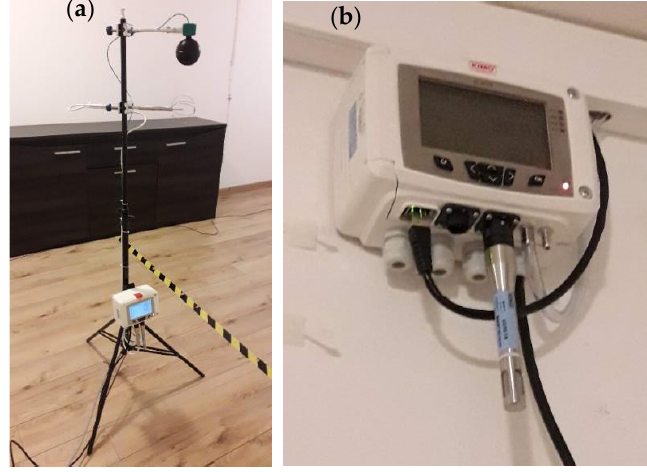
Figure 11. ( a ) a mobile measurement mast. ( b ) a psychrometric data logger.